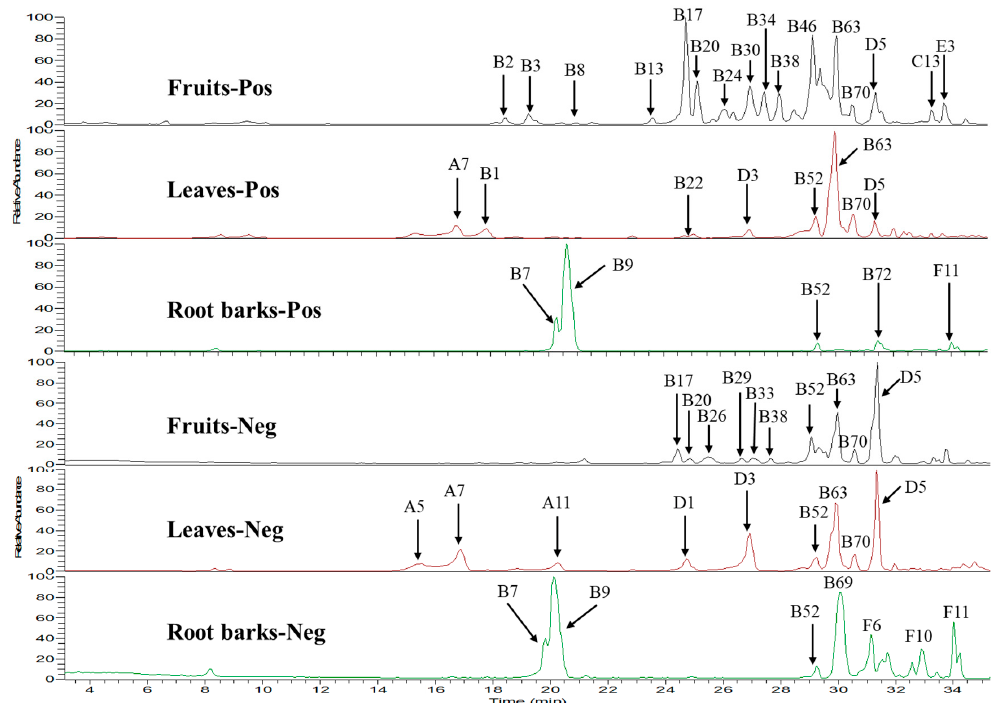
Figure 3. Total ion chromatograms (TICs) of extracts of fruits, leaves and root barks in positive and negative ion mode using UPLC-HR-MS. All the compound numbers were same with those shown in